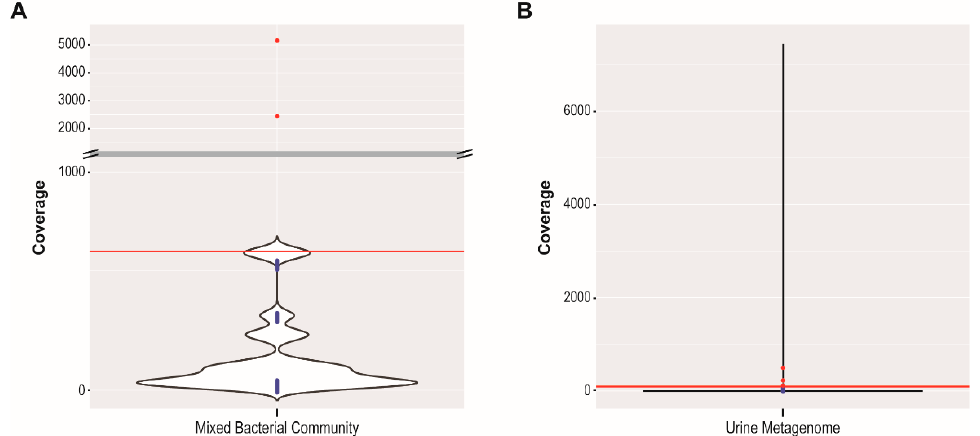
Figure 3. Density distribution of the coverage of the bacterial contigs from the ( A ) mixed community and ( B ) urine metagenome. The bacterial contig coverage values are shown by the density plot, where the width of the plot corresponds to the number of contigs with that coverage. The 99% threshold is shown by the red line. Predicted prophage sequences exceeding this threshold are shown as red circles, while predicted prophage sequences that do not meet this threshold are shown in blue circles. Density plots, such as those shown here, are automatically produced by PIE. Table 2. Urinary microbiome VirSorter2 predictions exceeding the 99%